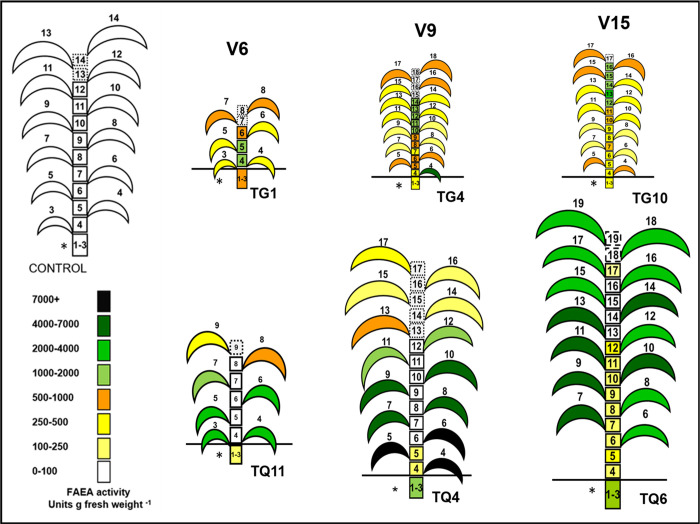
Comparison of overall FAEA activity in individual leaves and internodes of TG and TQ plants at three stages of development (V6 to V15).FAEA activity in leaves and internodes at V6, V9 and V15 developmental stages for TG1 and TQ11, TG4 and TQ4 and TG10 and TQ6. * indicates the fused internodes 1–3 or 1–4 and dotted lines refer to internodes that are not yet visible.